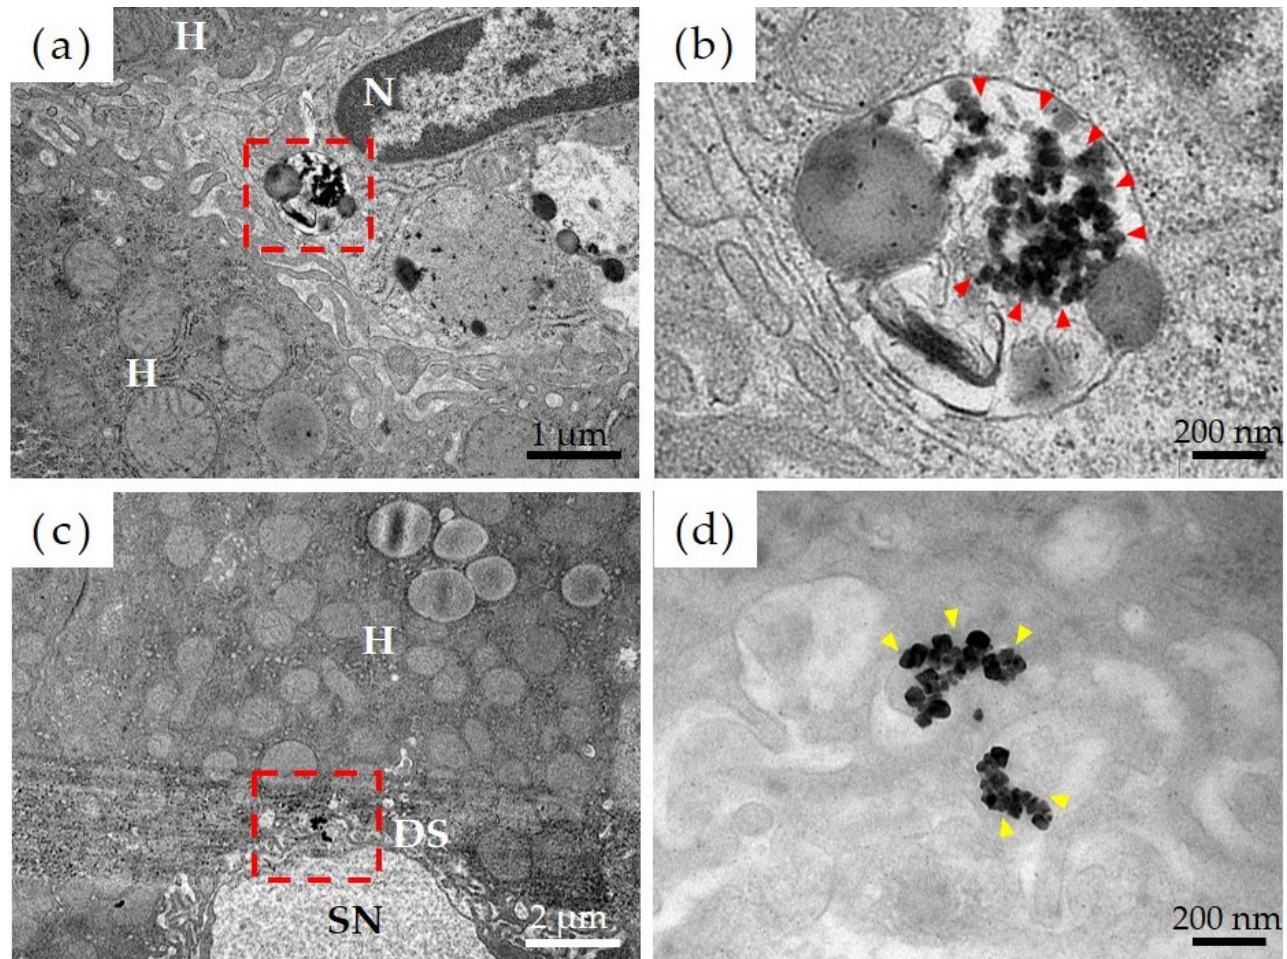
Figure 5. Evaluation of pharmacokinetics of nickel nanoparticles (Ni-NPs) via transmission electron microscopy. ( a , b ) Ni-NPs group, ( c , d ) Ion group; ( a , c ) low-power magnification image, and ( b , d ) high-power magnification image. The red frame in the low-power magnification image corresponds to the field of view from the high-power magnification image. The accumulation of Ni-NPs in phagolysosomes was observed in the Ni-NPs group (red arrowhead). Additionally, in the Ion group, the accumulation of Ni-NPs with a crystalline structure was observed (yellow arrowhead). H: hepatocytes, N: nuclei, SN: sinusoids; DS: Disse space.